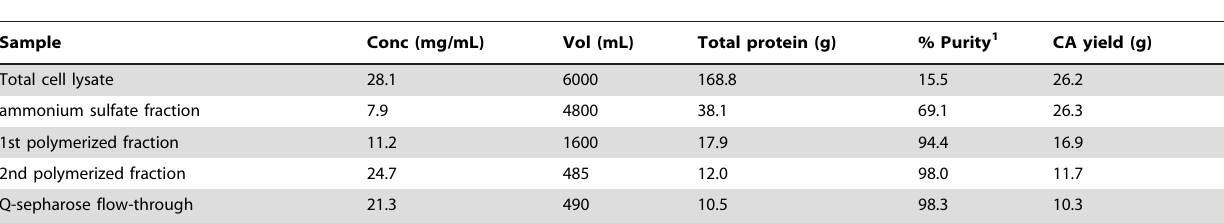
Table 1. Process summary of WT CA purification by polymerization.